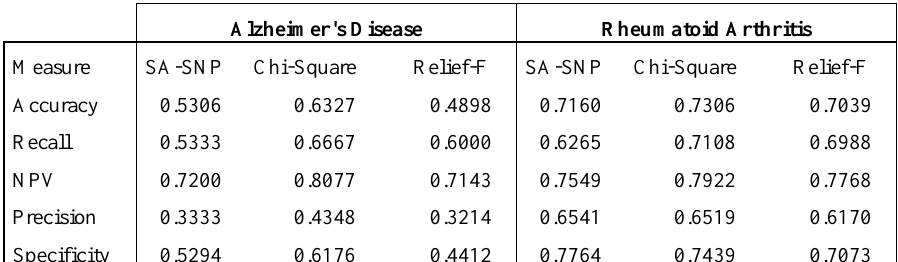
Table 14. 5-fold Cross Validation results for SA based selected list of SNPs over disease trait for AD and RA